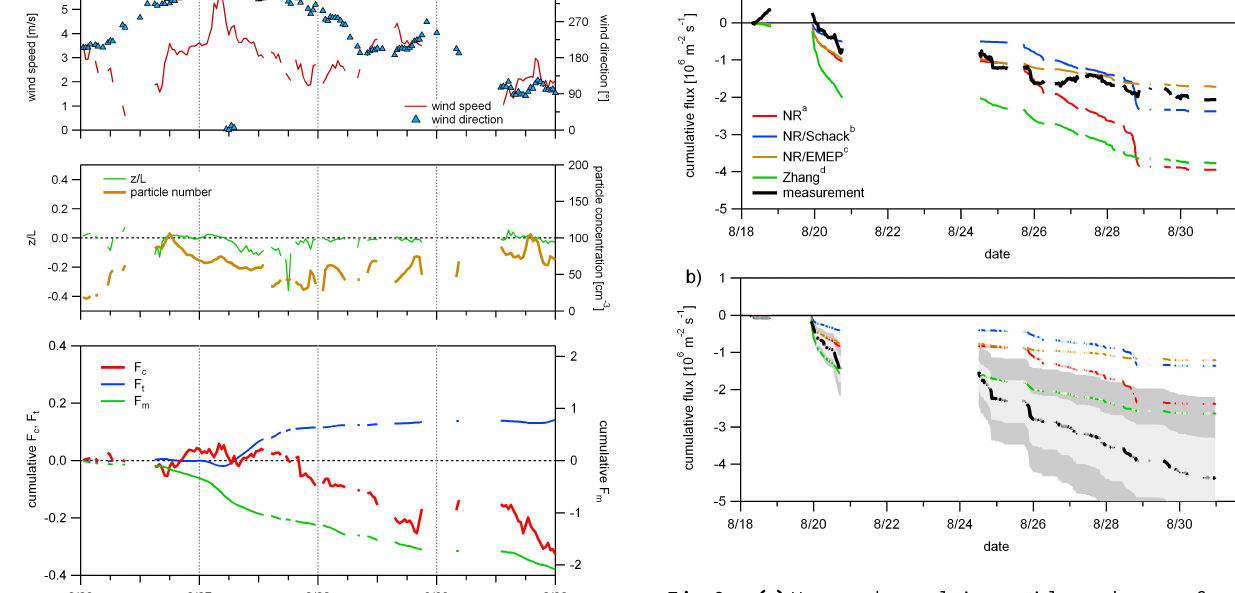
Fig. 6. (a) Measured cumulative particle number flux from 18 to 31 August (black line), and cumulative deposition fluxes de- rived from four different particle deposition parameterizations ac- cording to a Nilsson and Rannik (2001), b Schack et al. (1985), c EMEP (2003), d Zhang et al. (2001). (b) Same as Fig. 6a, but accumulating only during periods when particle deposition was ob- served. Emission dominated periods are indicated by light colors. Shaded areas represent deviations of 25% (light grey) and 50% (dark grey) from the observed deposition